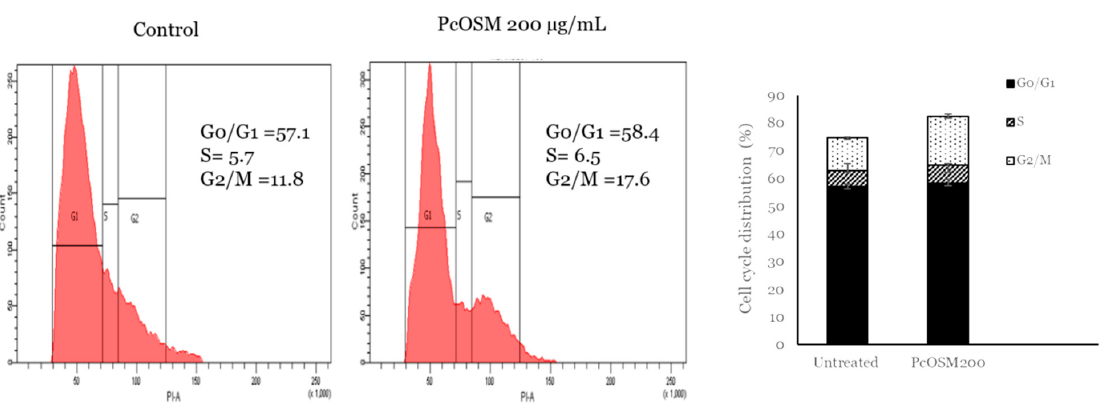
Figure 9. PcOSM induced cellular senescence in MDAMB231 cells: Senescence associated beta galactosidase assay (SA- β - Gal) staining of cells indicated concentration of PcOSM after 72 h. Cells were fixed and stained with fresh SA- β -Gal. PcOSM treated cells exhibited blue colour indicating senescent cells.